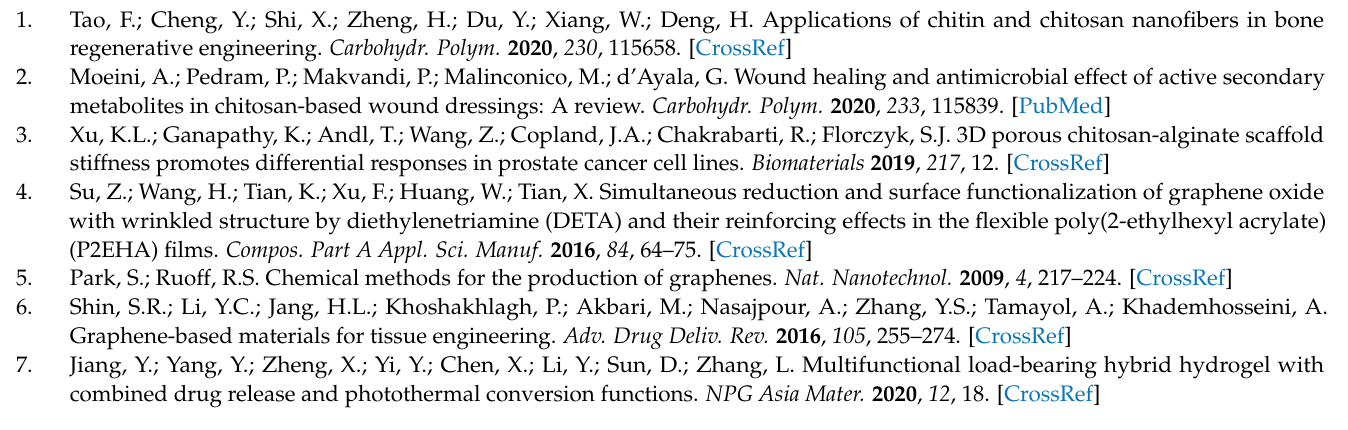
pure CS, CS/AgNPs and CS/AgNPs/GO scaffold; Table S2: The kinetic parameters for different drug release models; Figure S1: (a) The Raman spectra, and (b) X-ray diffraction (XRD) pattern of GO; Figure S2. TEM images and the associated nanoparticle size distributions for CS/AgNPs and CS/RB-AgNPs/GO-1.5; Figure S3. Antibacterial tests against (a) E. coli and (b) S. aureus , showing typical measurements of the diameter of the inhibition zone (inhibition length). Top left—pure CS; top right—CS/AgNPs; bottom left—CS/RB-AGNPs/GO-0.5; bottom right—CS/RB-AGNPs/GO-1.5; Figure S4. In-vitro release profile of single drug release system with each formulation; Figure S5. In-vitro release profile of dual drug release system with each